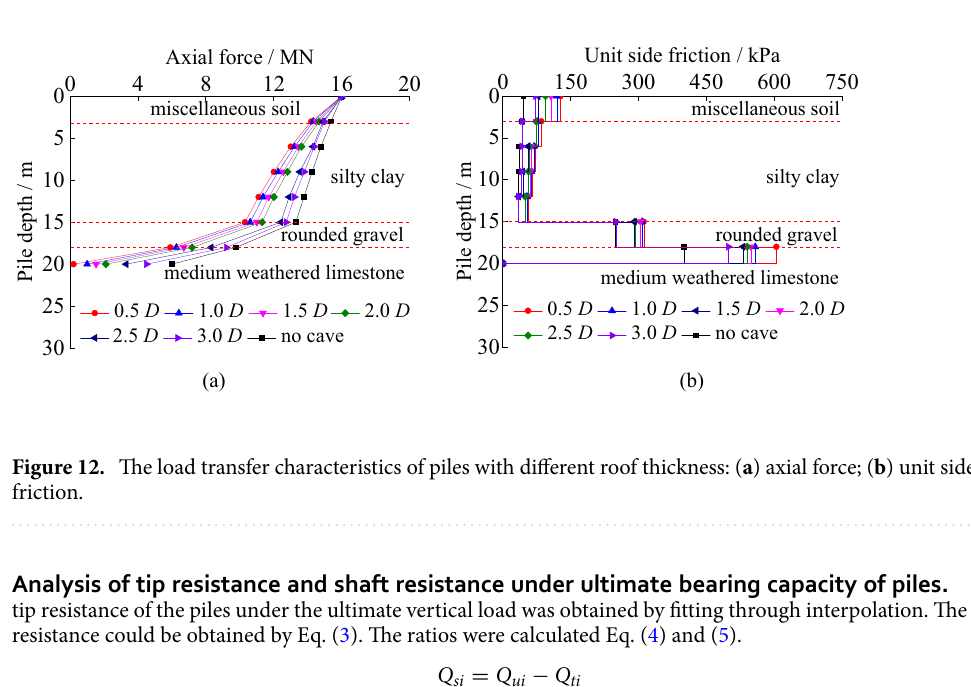
Figure 11. The load transfer characteristics of piles under different cave span: ( a ) axial force; ( b ) unit side friction.